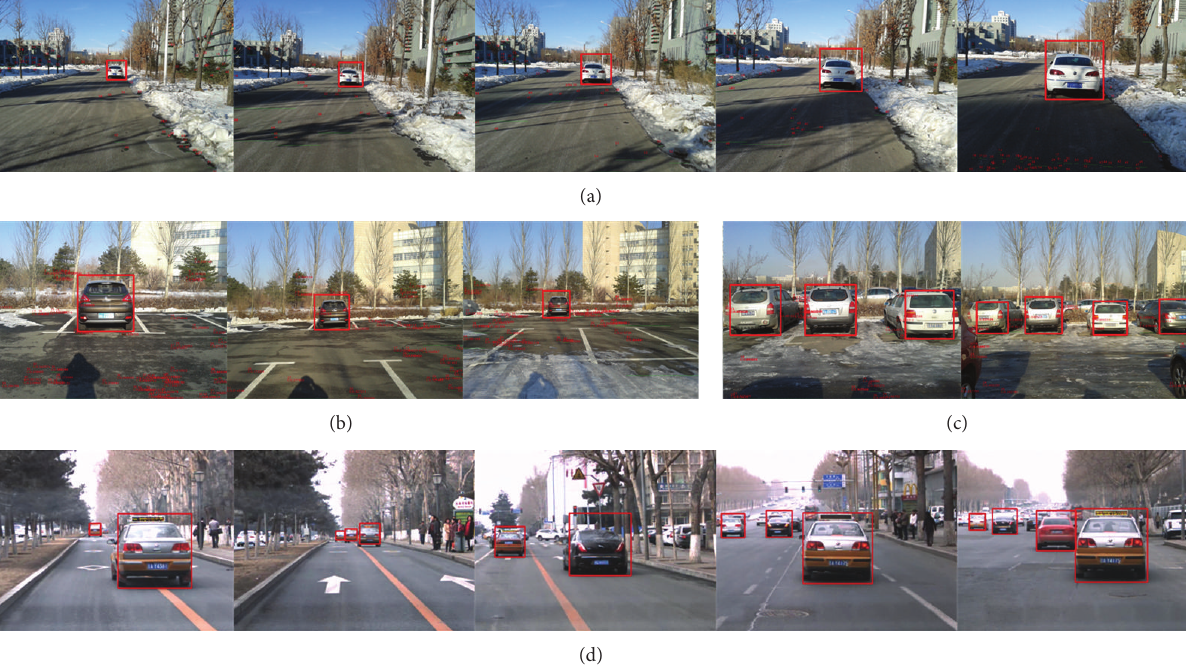
Figure 12: Detection results on our data